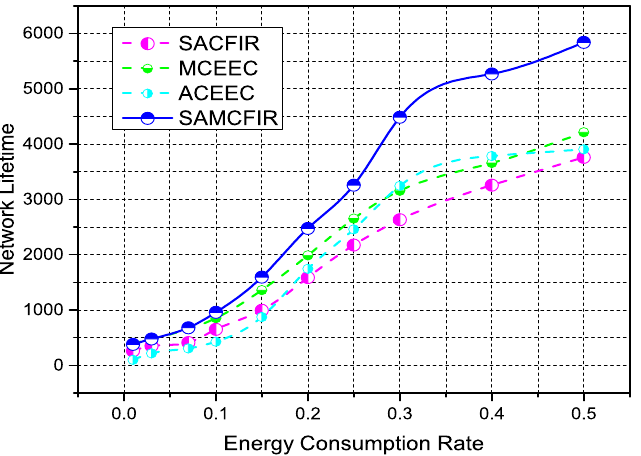
Figure 12. Energy consumption rate as network operation progress in network of 300 m × 300 m with 200 nodes.